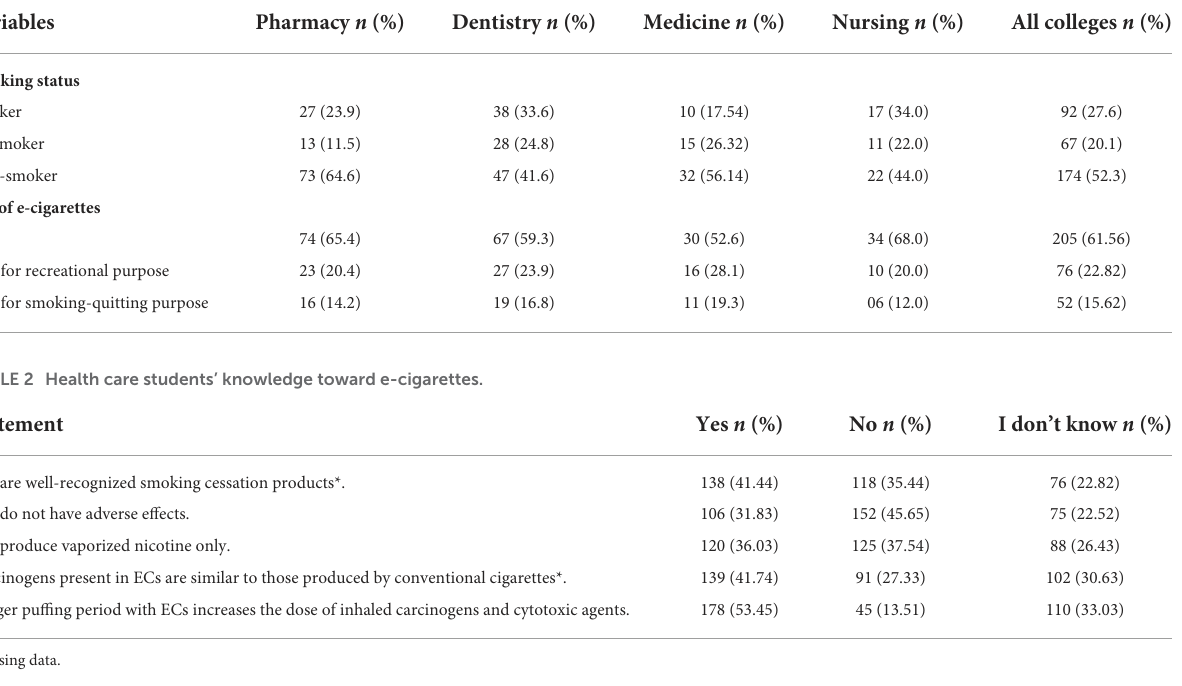
TABLE 3 Median score of knowledge toward e-cigarettes according to health colleges. Groups